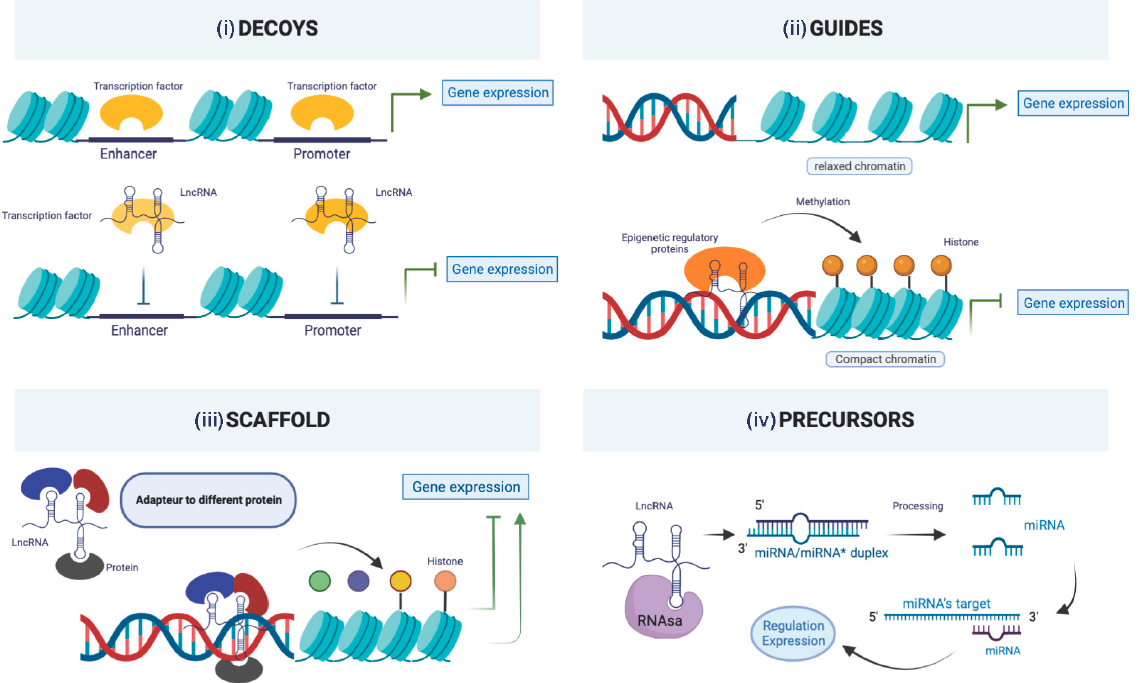
Figure 4. lncRNAs synthesis and functions. Four different archetypes of lncRNAs functions have been described; (i) lncRNAs can act as molecular signals occurring at a specific time and location to integrate developmental signals, interpret the cellular context, or respond to various stimuli, (ii) lncRNAs act as a molecular decoy by binding to their target proteins following transcription with mainly negative regulation, (iii) lncRNAs act as gene expression guides under a cis-form in the immediate vicinity of genes, and under a trans-form for distant genes, and (iv) lncRNAs act as